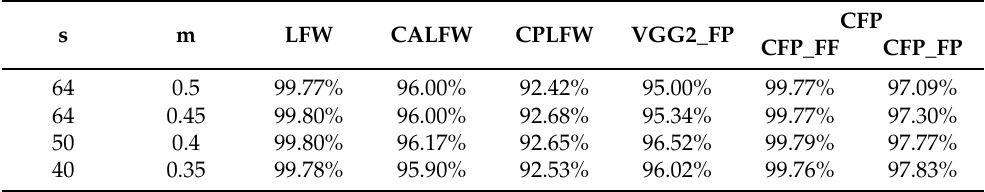
Table 6. The ablation study on different hyperparameters s and m with ResNet-100. The large-scale MS1M V3 dataset is chosen as the training